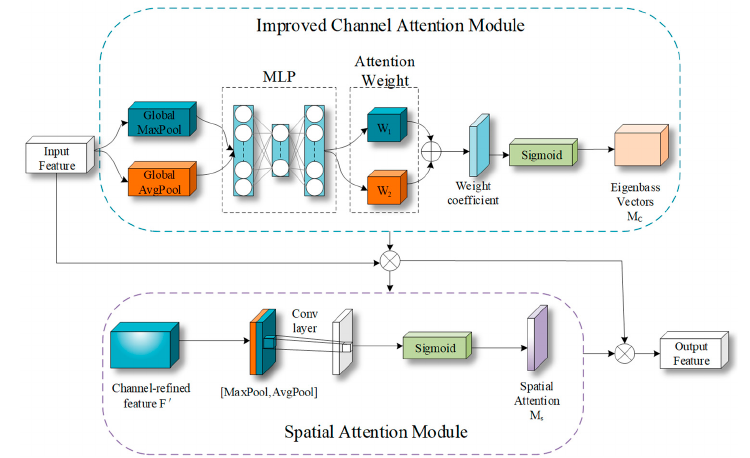
Figure 2. The framework of the proposed method.